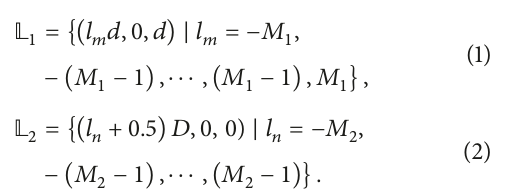
semiaxes. The sensor number of subarray X2 is N 2 =2 M 2 ; the distance between sensors of subarray X2 is D = N 1 d . The distance between subarrays X1 and X2 is also d. Suppose that there are q 2D ID narrowband sources with nominal angles ( 𝜃 푖 , 𝜑 푖 ) ( i =1,2, ⋅ ⋅ ⋅ , q ) impinging into the nested array. 𝜃 푖 denotes a spatial nominal azimuth between x axis and propagation path of the i th source; 𝜑 푖 is nominal elevation of the i th source. 𝜃 푖 ∈ [0, 𝜋] , 𝜑 푖 ∈ [0, 𝜋] . 𝜆 is the wavelength of the impinging